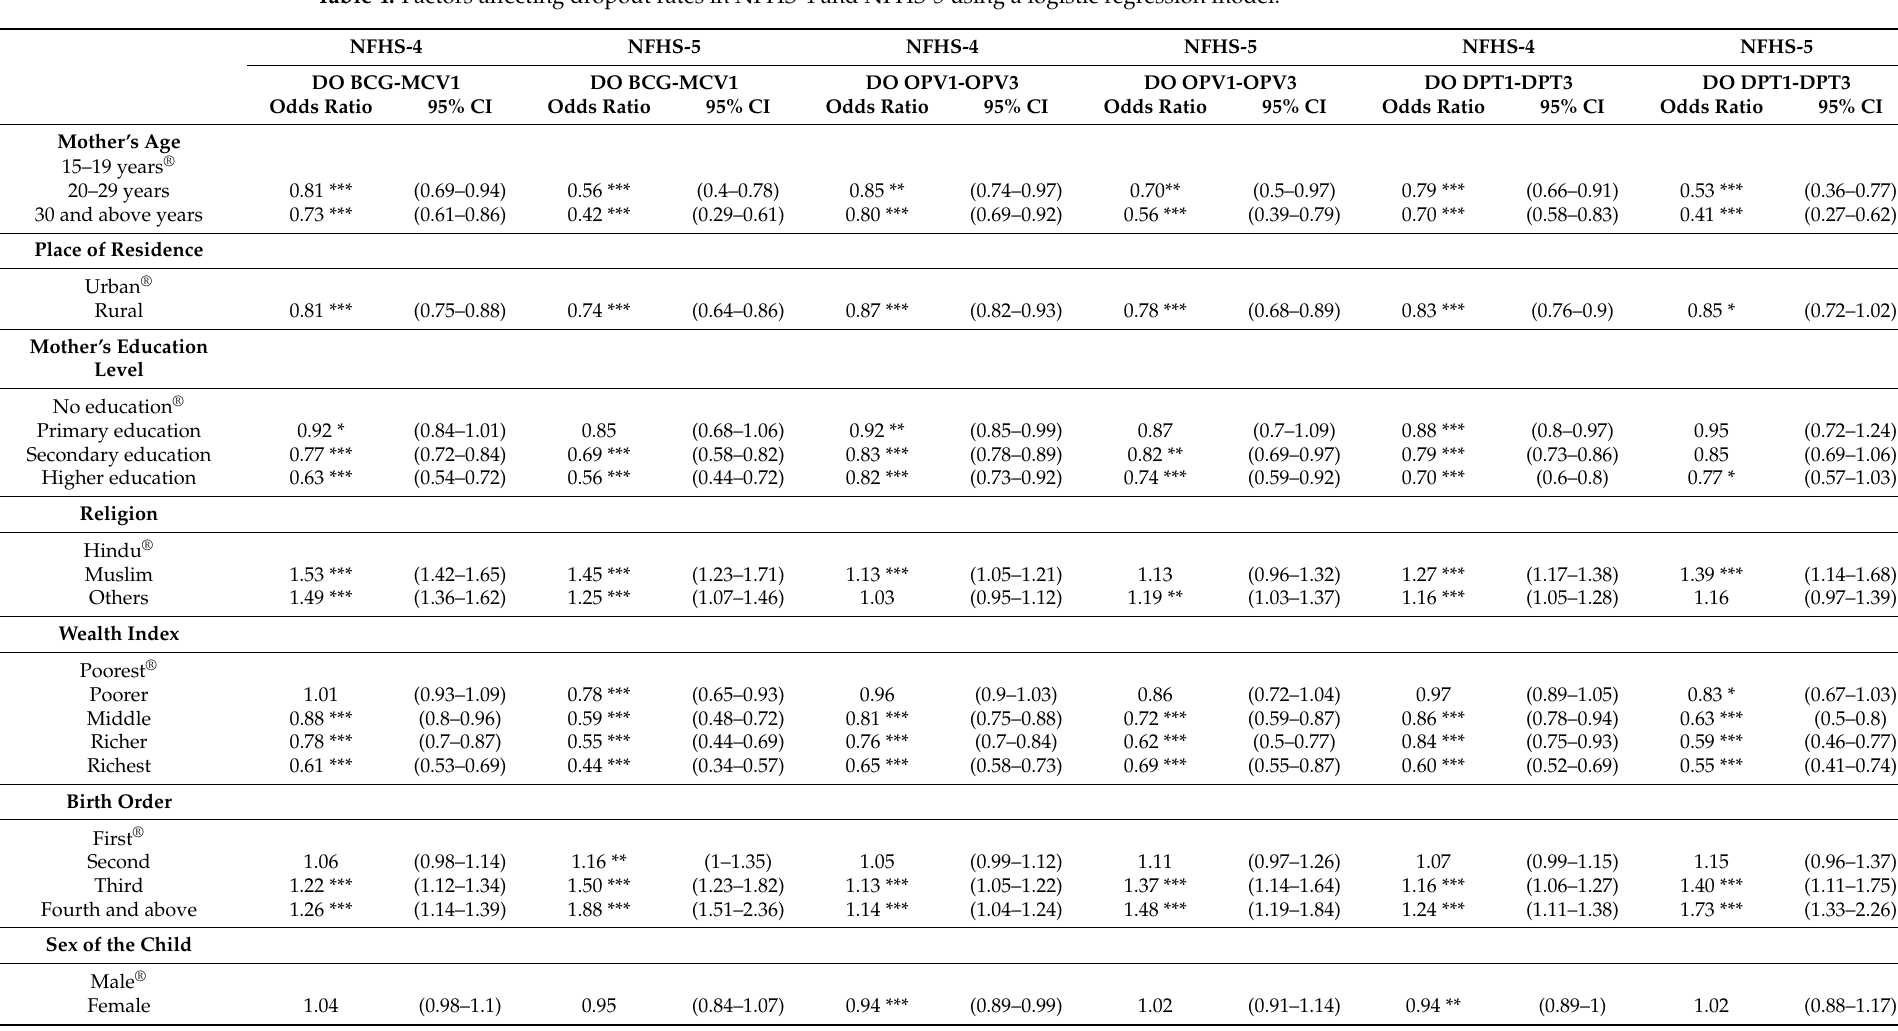
Table 4. Factors affecting dropout rates in NFHS-4 and NFHS-5 using a logistic regression